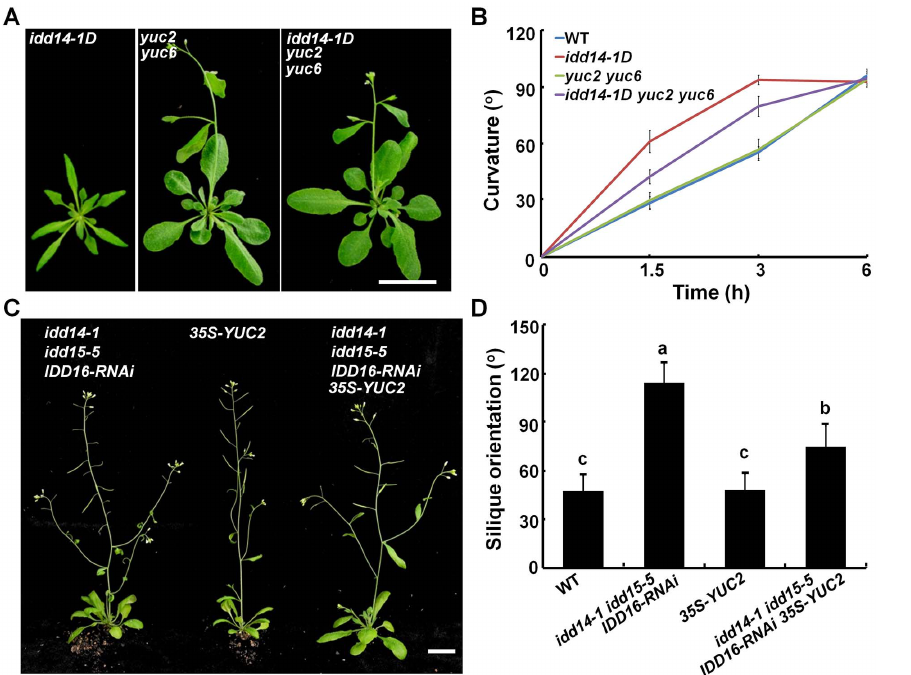
Figure 8. Genetic interaction of auxin biosynthesis and IDD-mediated organ morphogenesis and gravitropism. (A) Aerial organ morphology of 25-day-old idd14-1D , yuc2 yuc6 , and idd14-1D yuc2 yuc6 plants. The scale bar represents 2 cm. (B) Gravitropic responses of WT, idd14- 1D , yuc2 yuc6 , and idd14-1D yuc2 yuc6 inflorescence stems. (C) 45-day-old plants of the idd triple mutant, 35S - YUC2 , and idd triple mutant carrying a p35S::YUC2 construct. The scale bar represents 2 cm. (D) The silique orientation of WT, idd triple mutant, 35S - YUC2 , and idd triple mutant carrying a p35S::YUC2 construct (one-way ANOVA test, P , 0.05).